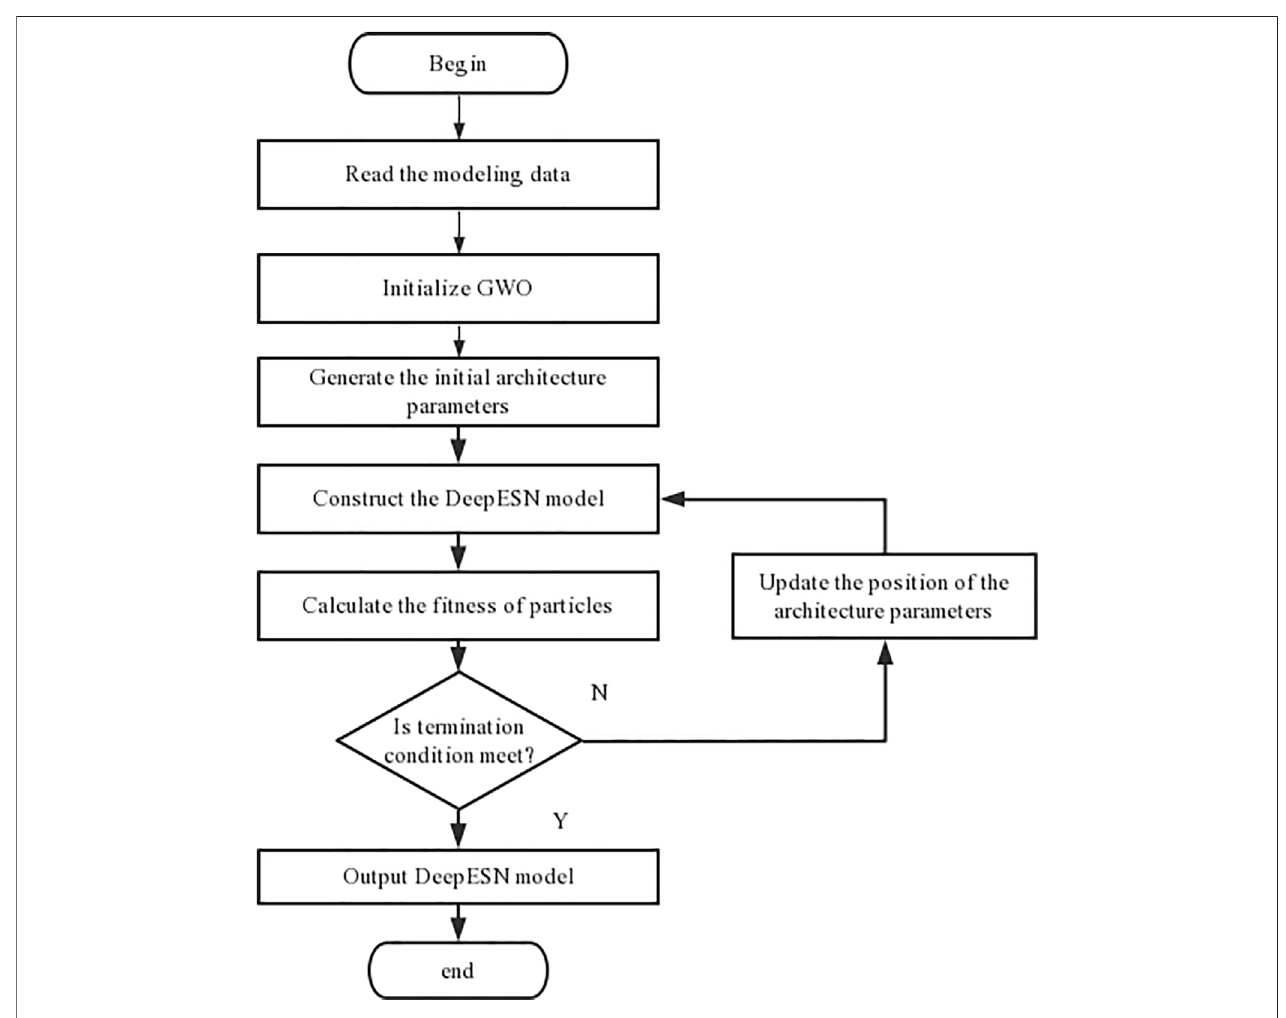
FIGURE 2 | A fl owchart of the proposed modeling